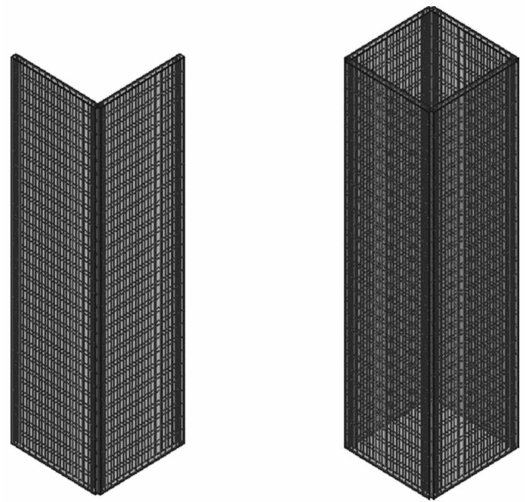
Figure 11. Shear wall samples.